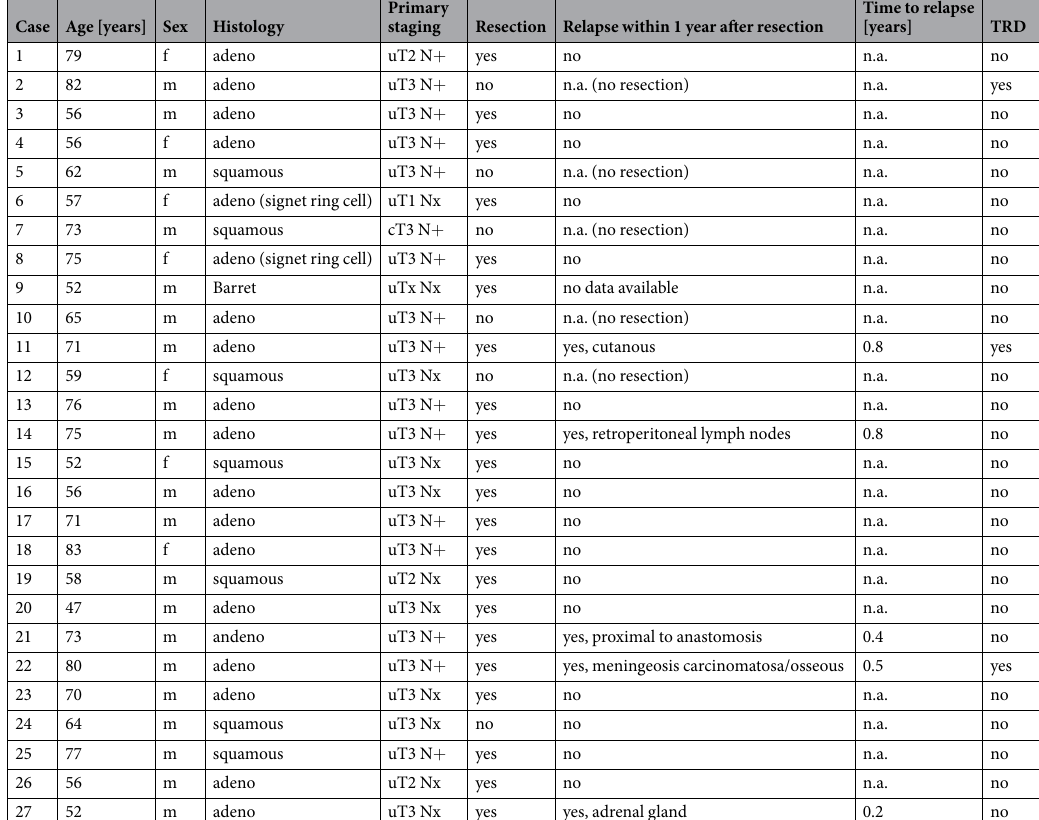
Table 1. Patient cohort. Within the current study patients with locally advanced oesophageal cancer of both histopathological subtypes (adenocarcinoma and squamous cell carcinoma) were included. The patients’ blood was sampled during endoscopy in primary staging. Most patients underwent surgical resection with/ without neoadjuvant radio-chemotherapy. In six cases no surgery was carried out due to the patients’ functional situation or individual wish. TRD: tumour related death, m: male, f: female, n.a.: not